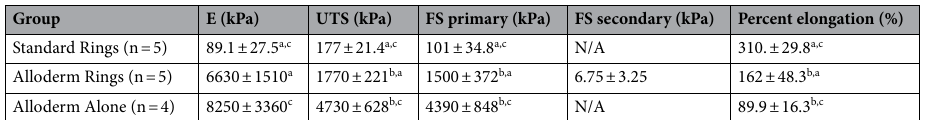
Group E (kPa) UTS (kPa) FS primary (kPa) FS secondary (kPa) Percent elongation (%) Standard Rings (n =